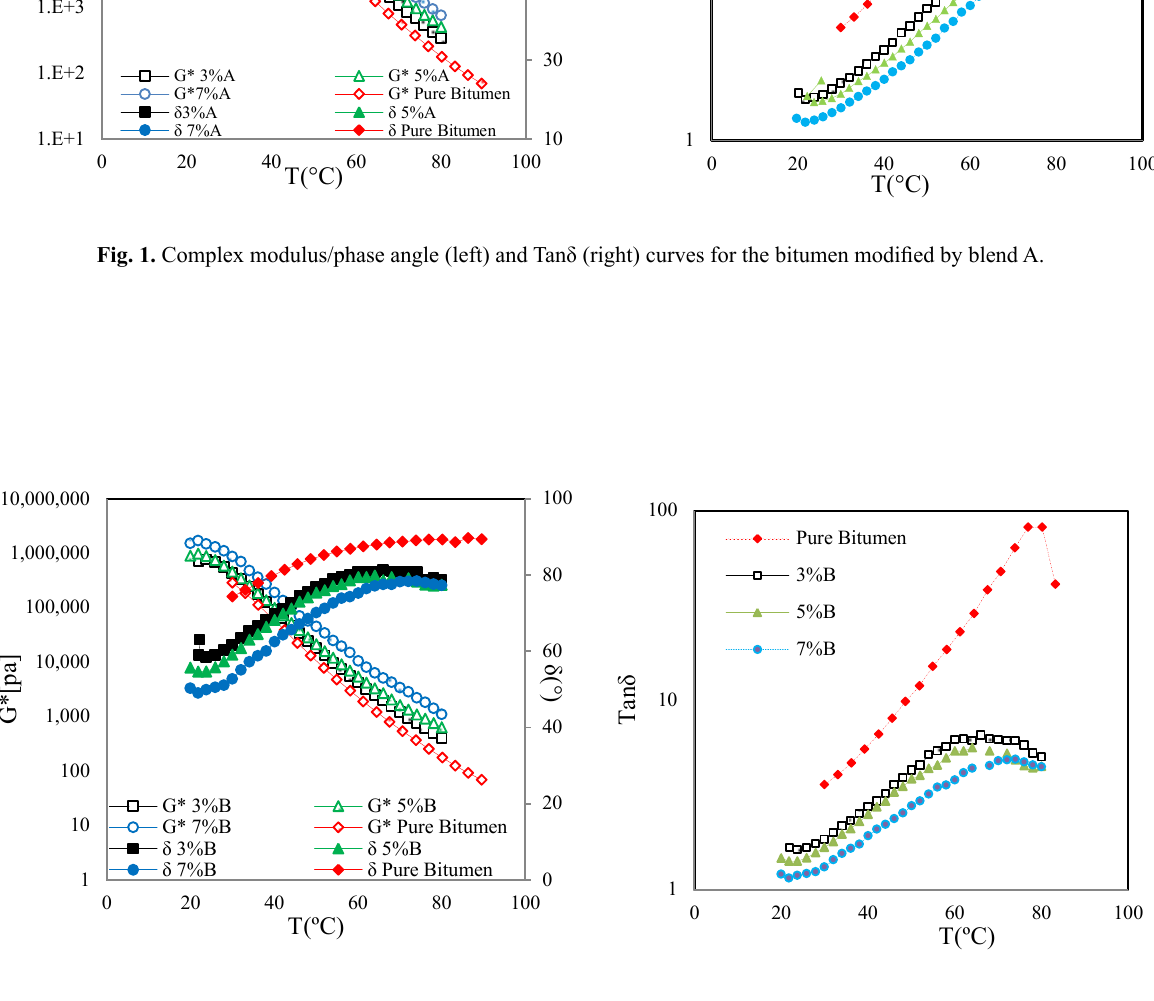
Fig. 2. Complex modulus/phase angle (left) and Tanδ (right) curves for the bitumen modified by blend